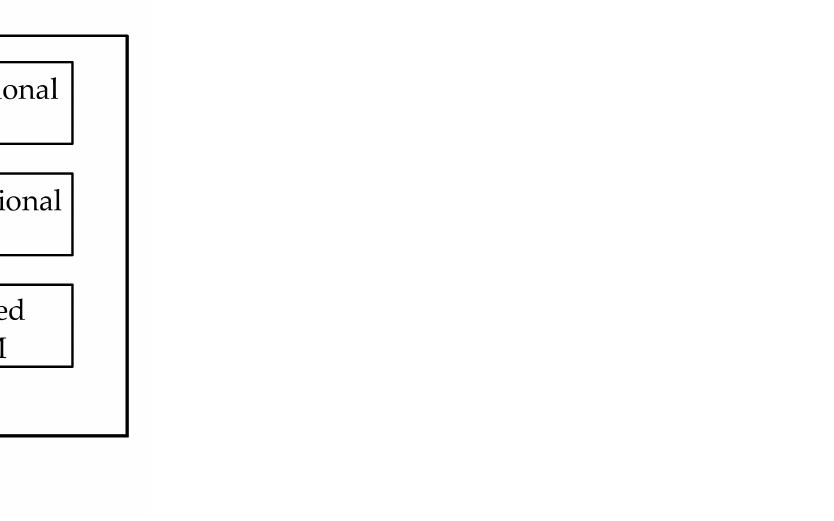
Figure 10. Location of the improved CBAM in the residual unit.